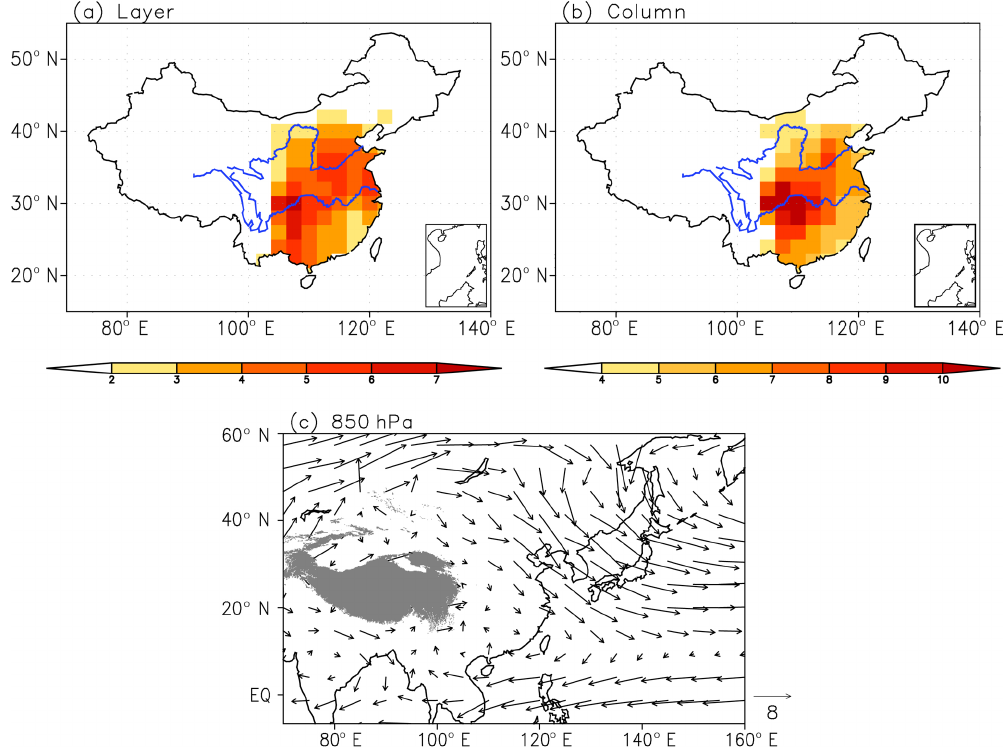
Figure 2. The standard deviation of the simulated (a) surface-layer PM 2 . 5 concentrations (µgm − 3 ) and (b) column burdens of PM 2 . 5 (mgm − 2 ) during boreal winter averaged from 1986 to 2006. (c) The horizontal distribution of boreal winter climatological mean wind at 850hPa (ms − 1 ) ; shading indicates the Tibetan Plateau.